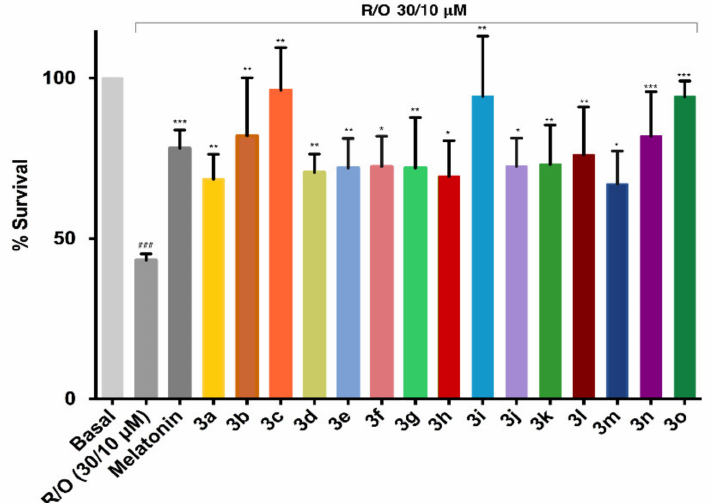
Figure 5. Survival (%) of SH-SY5Y cells subsequent to the administration of the combination of rotenone (30 µ M) and olygomicin A (10 µ M) in the presence of compounds 3a – 3o (1 µ M), with melatonin as a positive control. Data were obtained from three experiments by triplicate and are given as mean ± SEM. One-way ANOVA Newman–Keuls post-test: ### p < 0.001 compared to basal; * p < 0.05, ** p < 0.01, *** p < 0.001 compared to toxic. Numerical data are given in the Supplementary Materials (Table